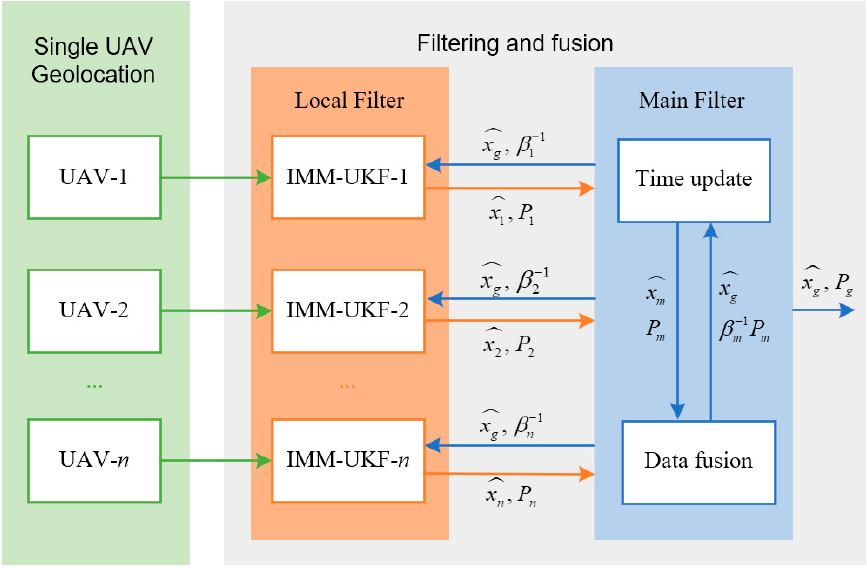
Figure 8. The framework of the state estimator.